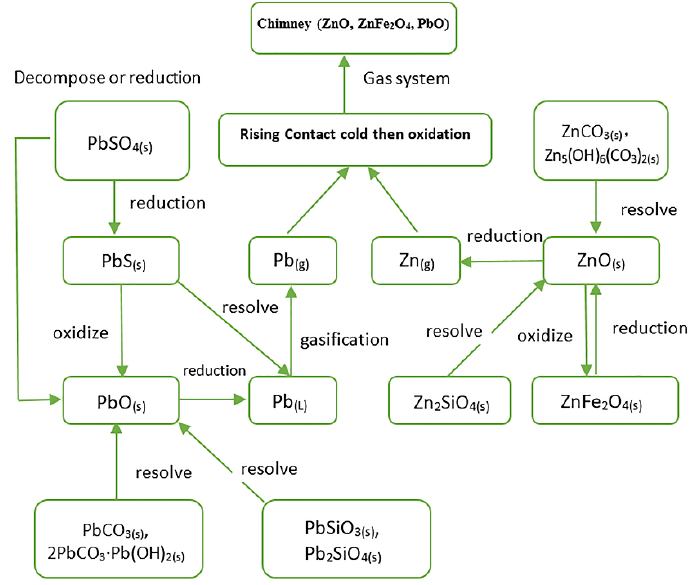
Figure 8. Reduction process of Pb and Zn materials in BF.